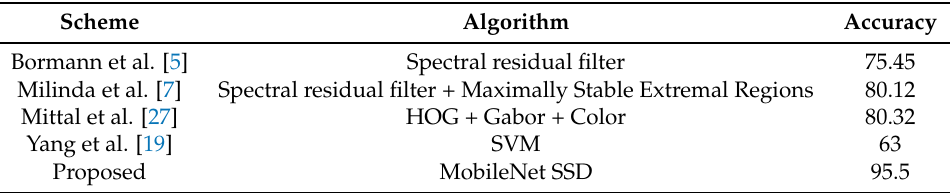
Table 7. Comparison with schemes not based on deep